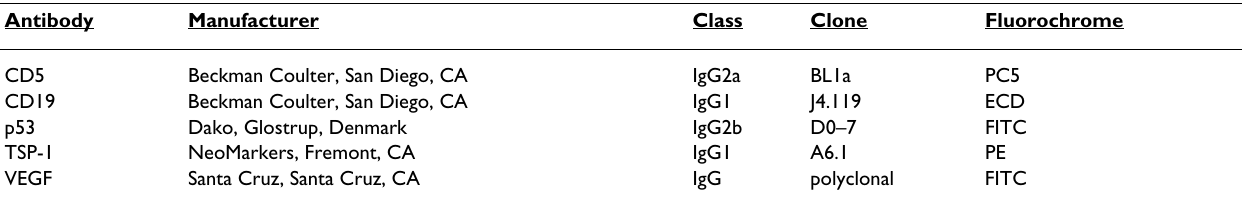
Table 2: Antibodies used for flow cytometry